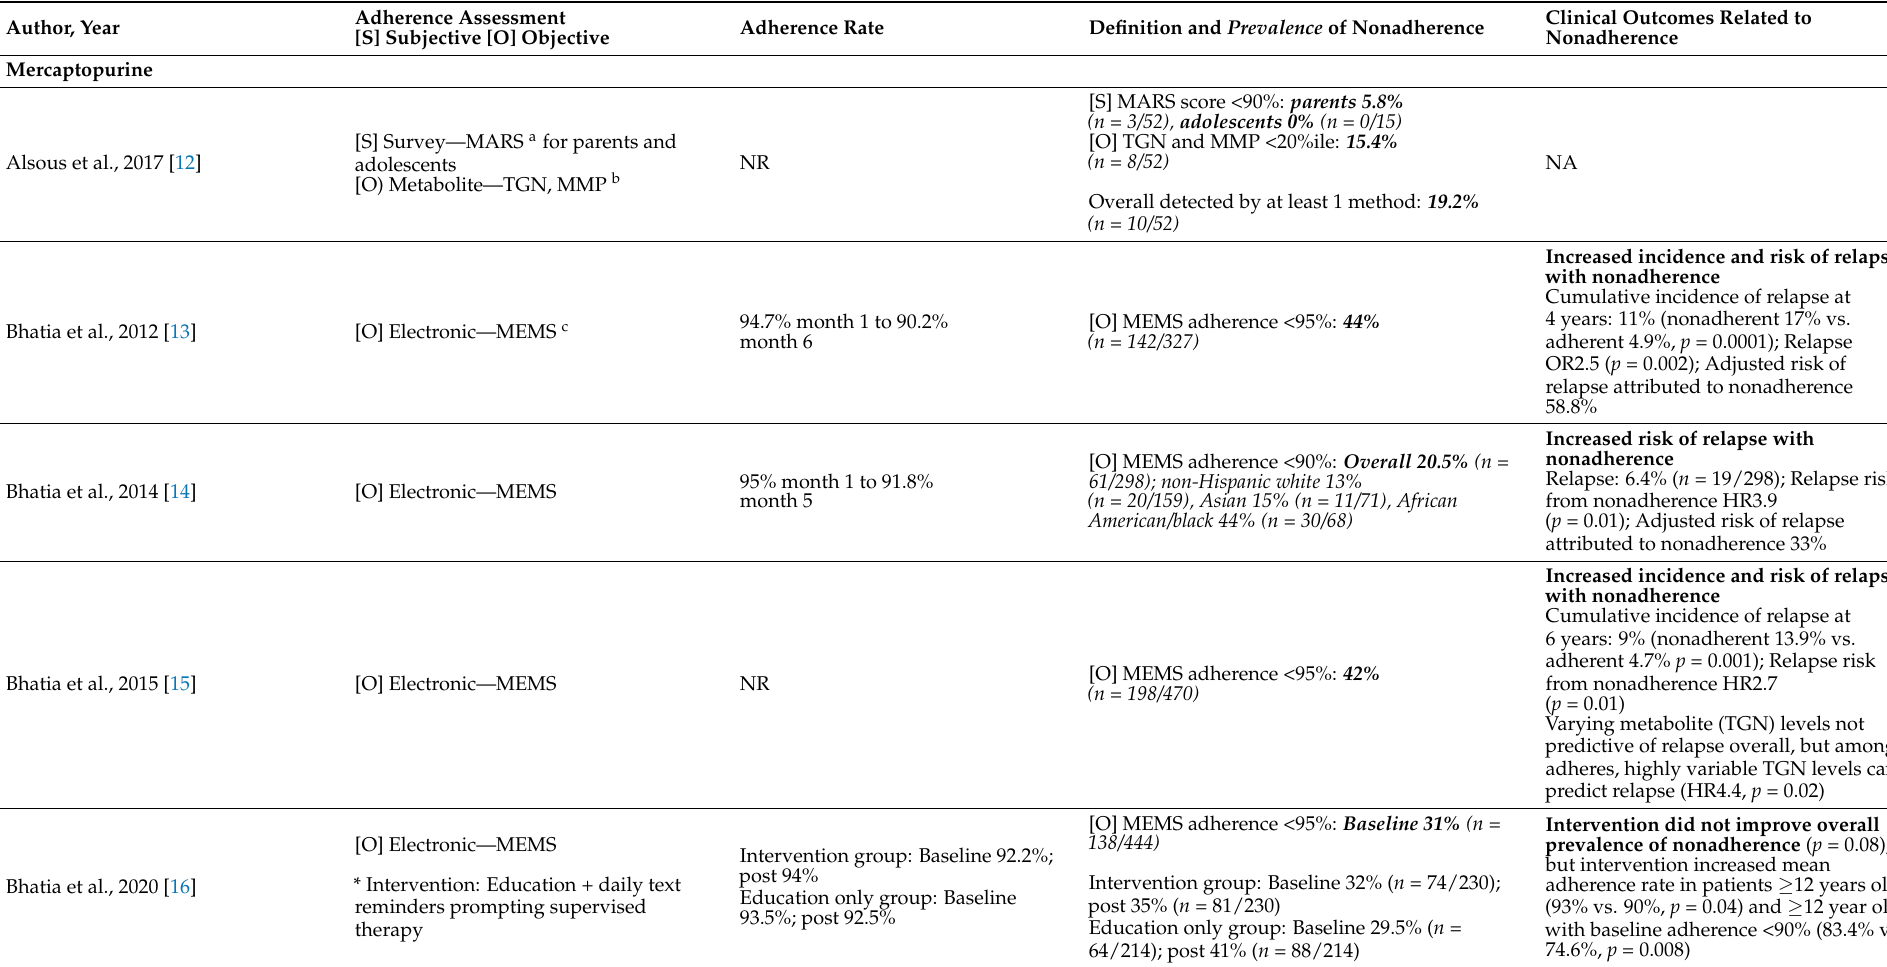
Table 2. Assessment of nonadherence and clinical